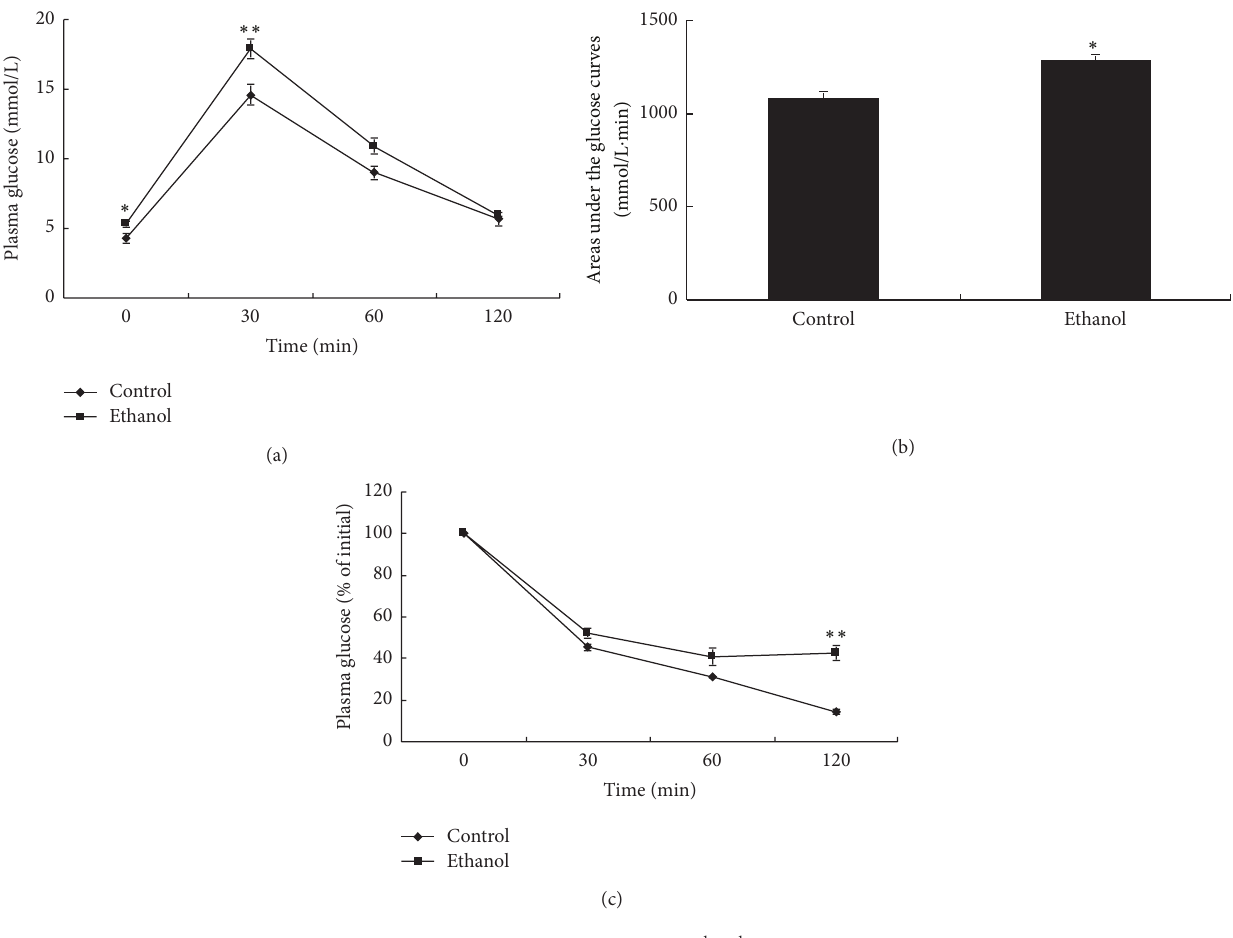
Figure 1: Glucose and insulin tolerance after 3 months of ethanol intake (8g ⋅ kg −1 ⋅ d −1 ). Plasma glucose concentrations during intraperitoneal glucose tolerance test (IPGTT), the area under the IPGTT glucose curve, and the glucose concentrations during insulin tolerance test (ITT) are shown as the mean ± S.E.M ( 𝑛 = 20 ). ∗ 𝑃 < 0.05 , ∗∗ 𝑃 < 0.01 ethanol versus